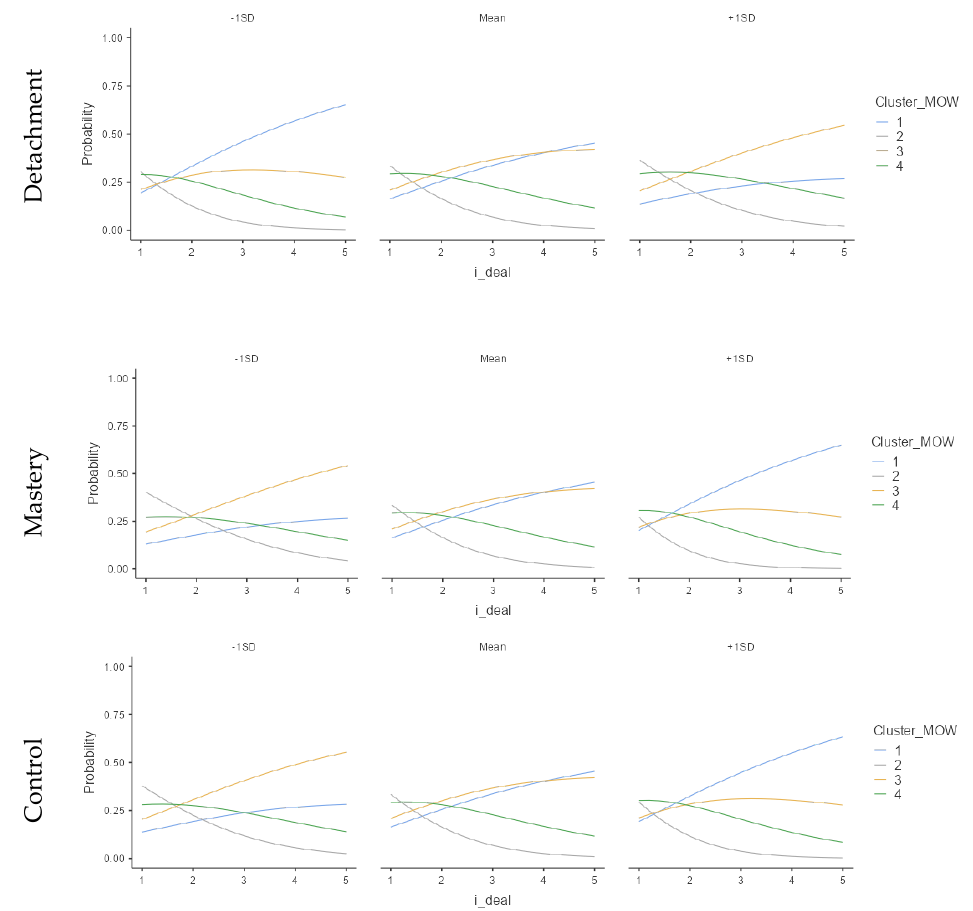
Table 2 describes the multinomial regression, before and with moderation variables.